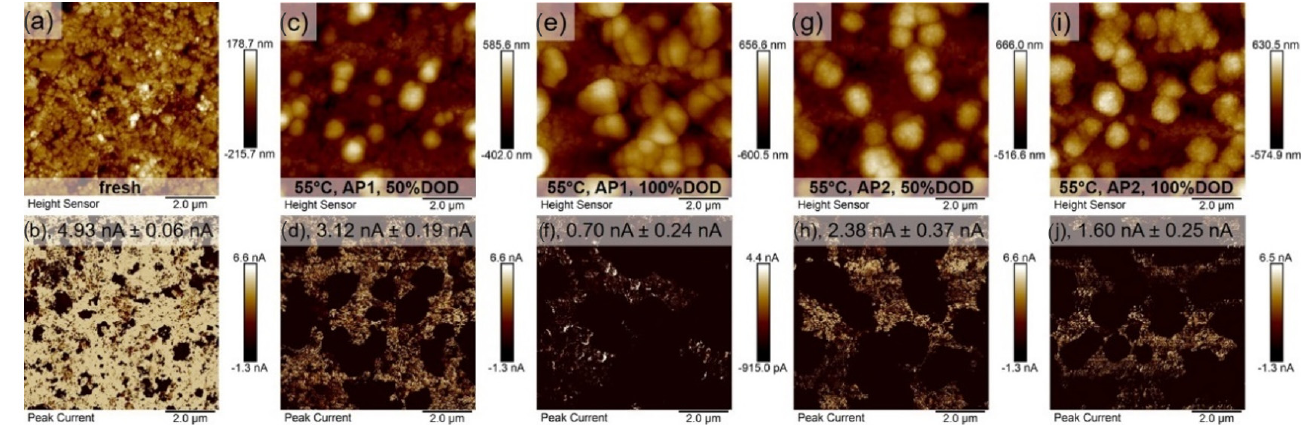
Figure 13. Topography ( a – i ) and the average current magnitude ( b – j ) of the cathodes [64].